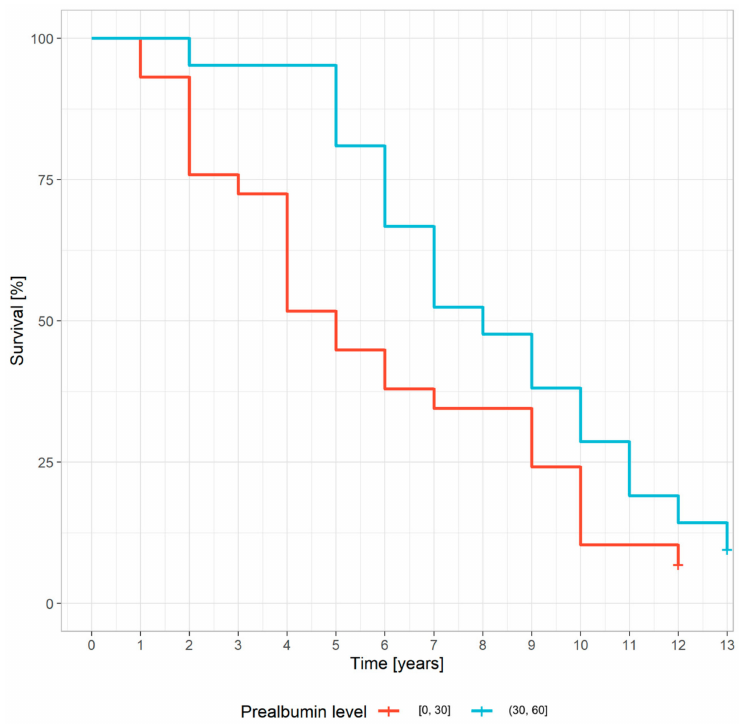
Figure 1. The relationship between serum prealbumin concentration and survival (Kaplan–Meier estimates) (the blue and red lines represent prealbumin concentration ranges [mg/dL]).